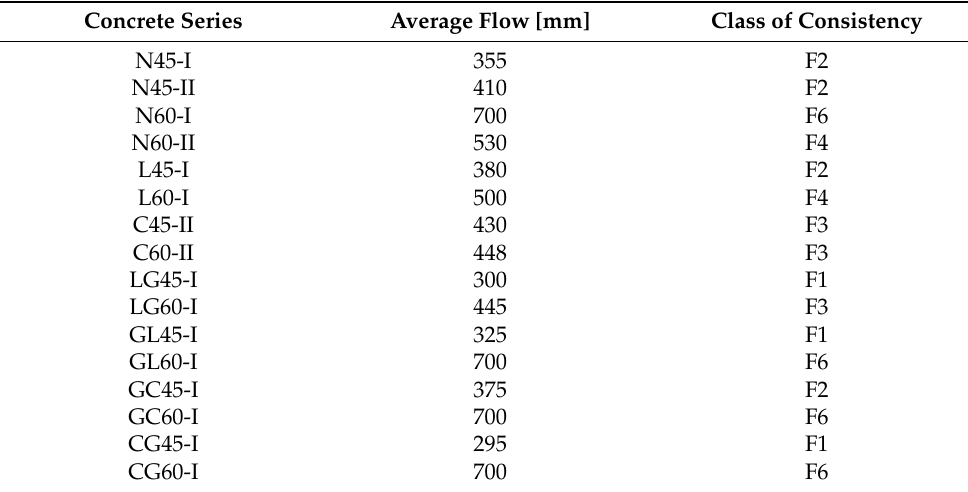
Table 3. Consistency of concrete mixtures according to EN 12350-5:2011